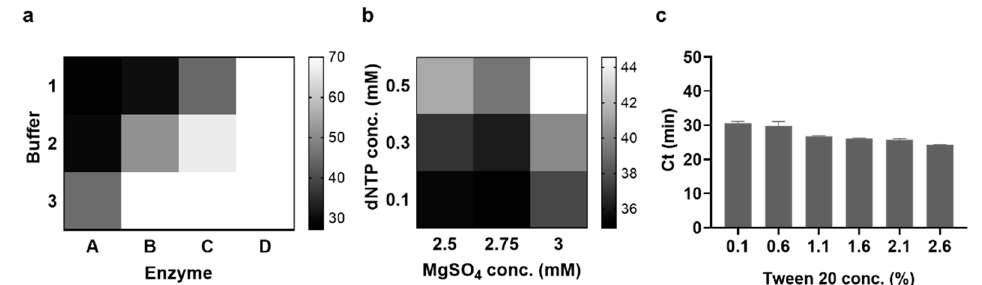
Figure 3. Optimization of reaction conditions for low-temperature LAMP. ( a ) Ct values according to the different combinations of DNA polymerase and reaction buffers. A, B, C, and D indicate Bst 2.0 DNA polymerase, Klenow DNA polymerase exo-, Bsu DNA polymerase large fragment, and phi29 DNA polymerase, respectively, while 1, 2, and 3 indicate 1× isothermal amplification buffer, 1× phi29 DNA polymerase buffer, and 1× NEBuffer™ 2, respectively. ( b ) Ct values according to the different concentrations of MgSO 4 and dNTPs. The concentration of SLP (C22) was 5 pM. ( c ) Ct values according to the different concentrations of Tween 20. The concentrations of MgSO 4 and dNTPs were 2.75 mM and 0.1 mM, respectively, and the concentration of SLP (C22) was 50 pM. All tests were performed with three technical replicates.